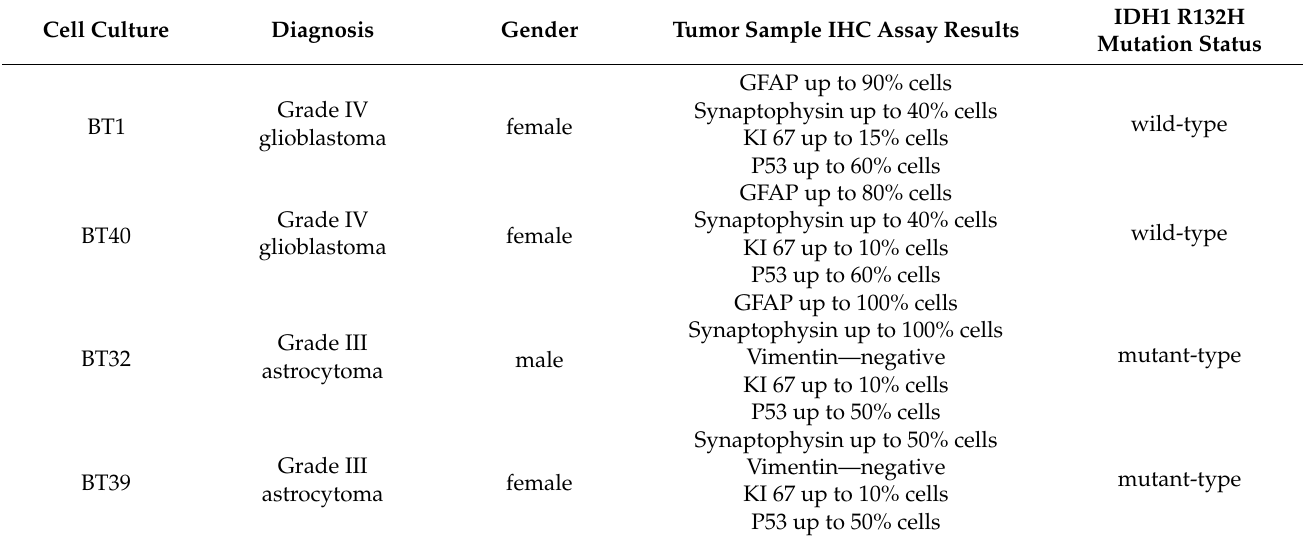
Table 1. Glioma primary cell cultures derived from the patients’